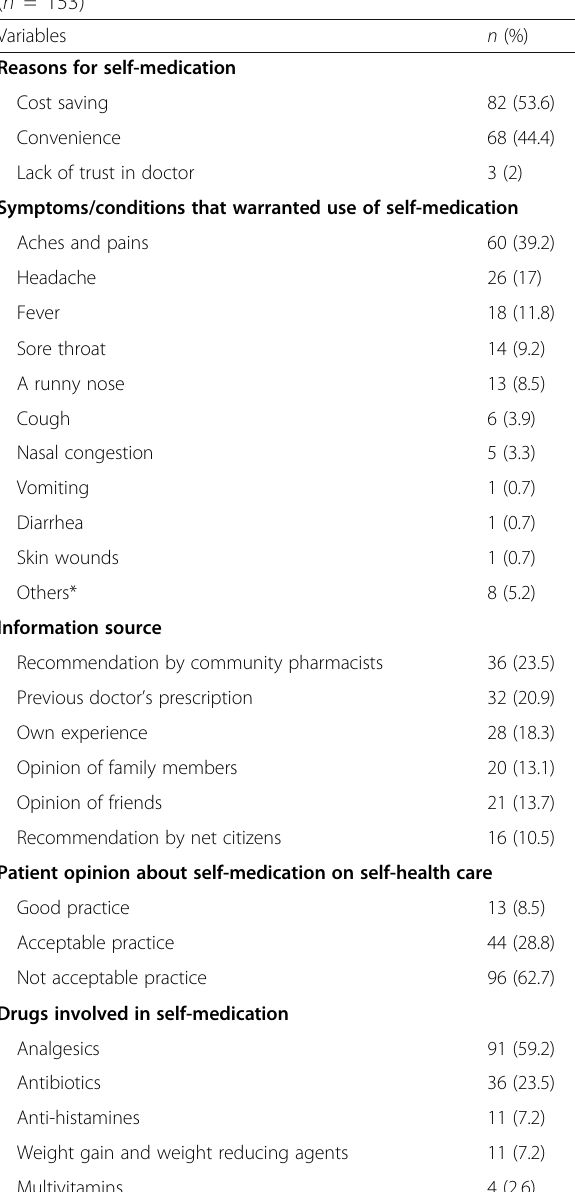
Table 1 Items related to self-medication in the study sample